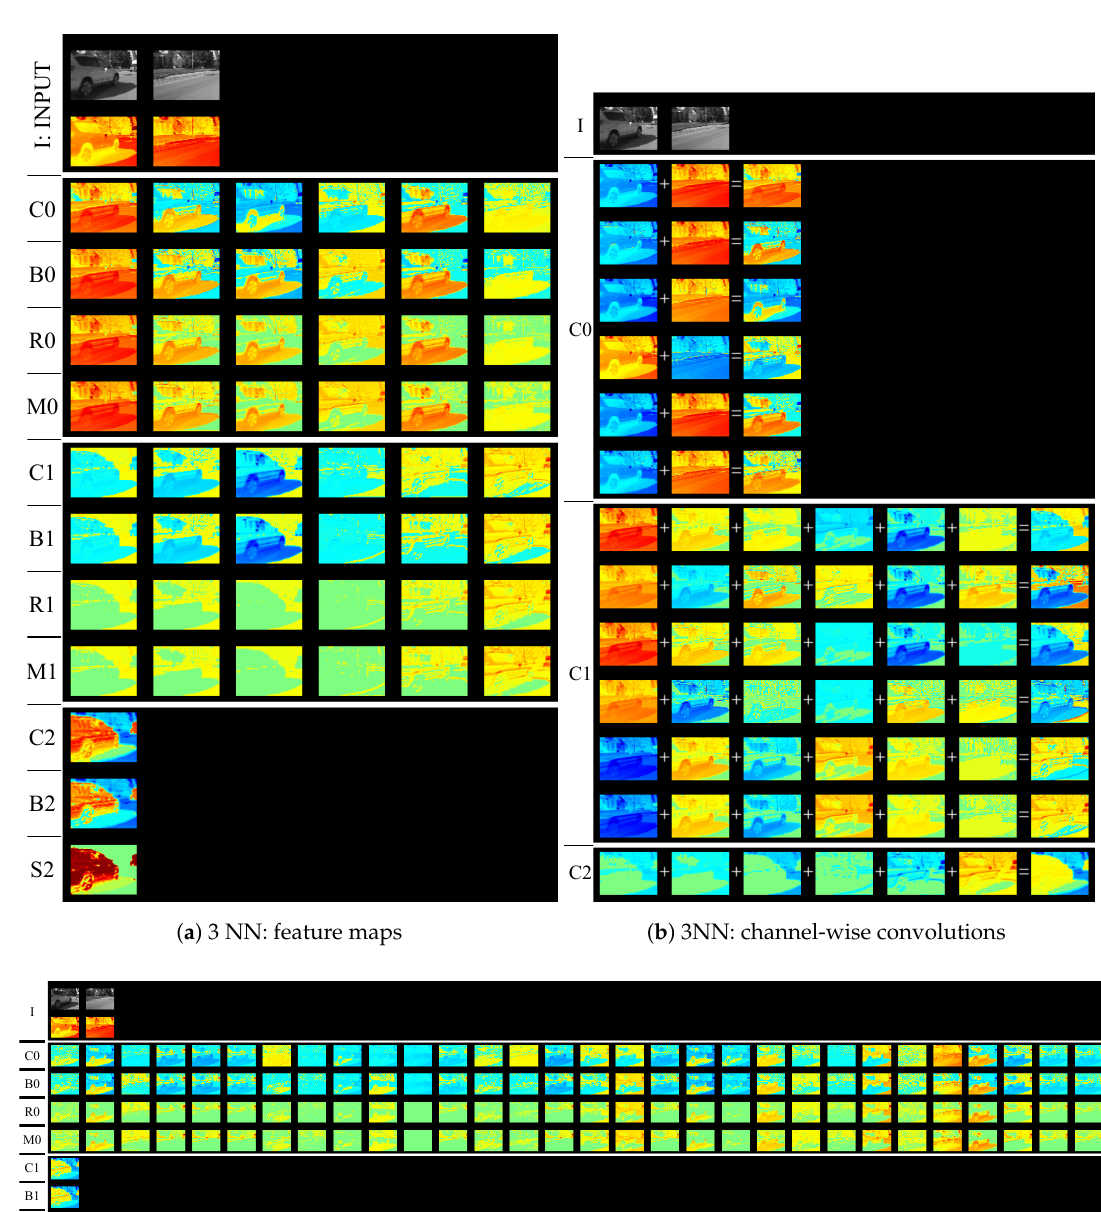
Figure 5. Visualization of feature maps in 3NN and 2NN-large trained on bungalows sequence. We visualize feature maps in each sub-layer and channel-wise convolution as in Figure 1. The abbreviations C, B, R, S, and M mean convolution, bias, ReLU, sigmoid, and max-pooling layer, respectively. Channel-wise convolutions of 2NN-large are excluded because of space